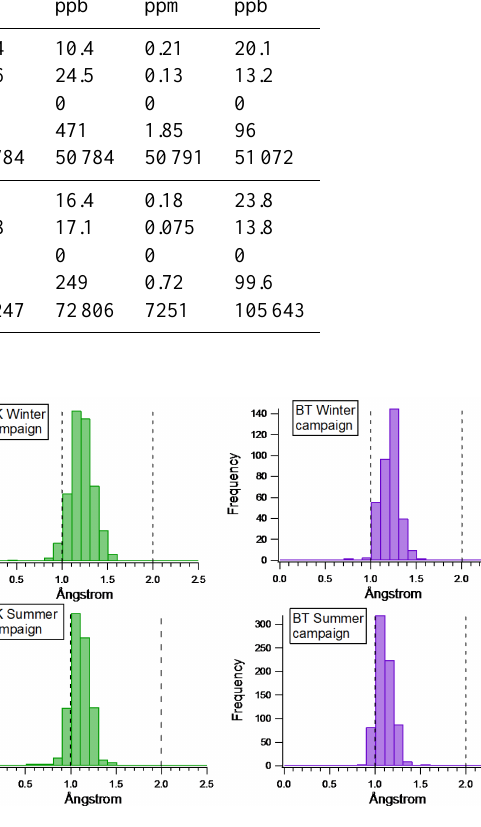
Figure 12. Histogram of Ångstrom coefficients for winter and sum- mer campaigns at NK and the BT